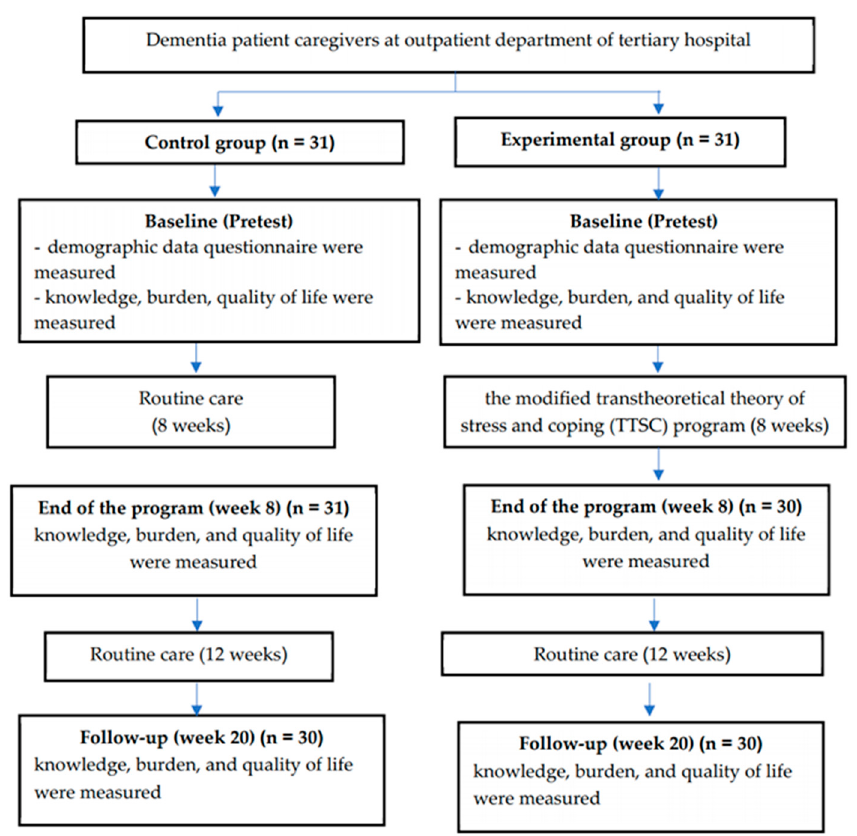
Figure 1. Process of data collection of the study.